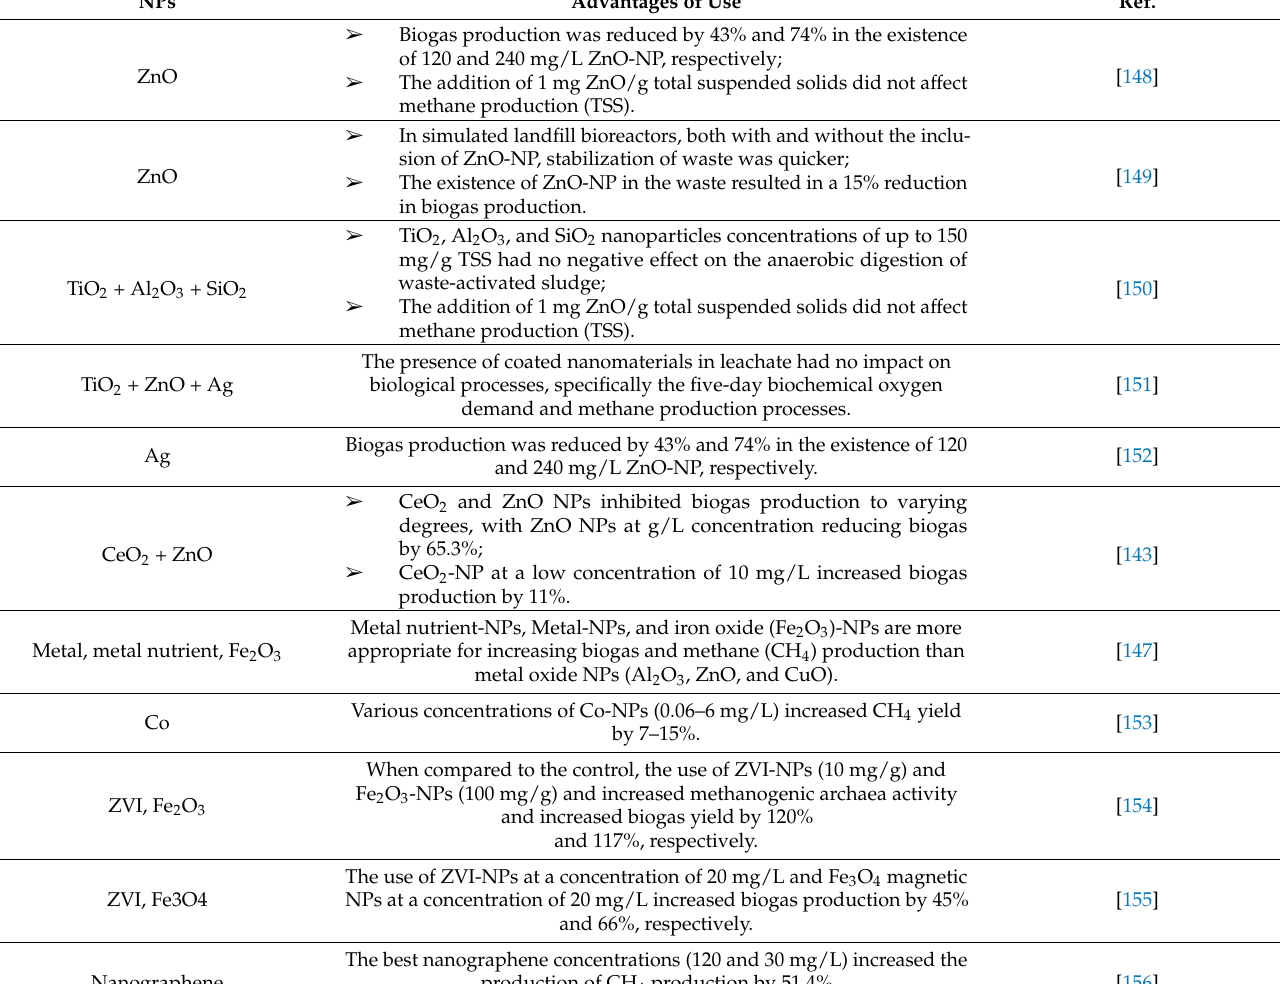
Table 6. Summary of biogas